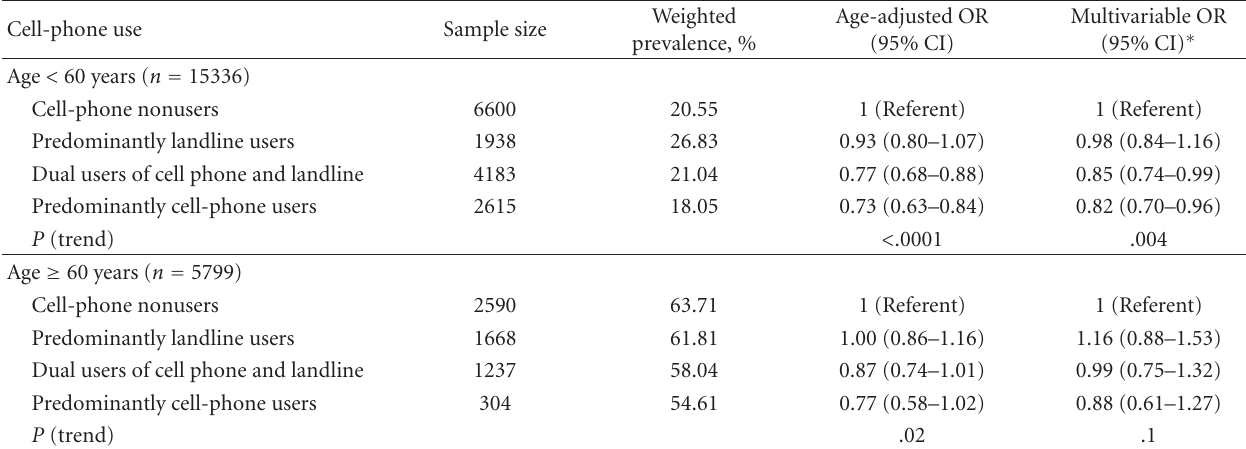
Table 3: Association between cell-phone use and hypertension by age groups.